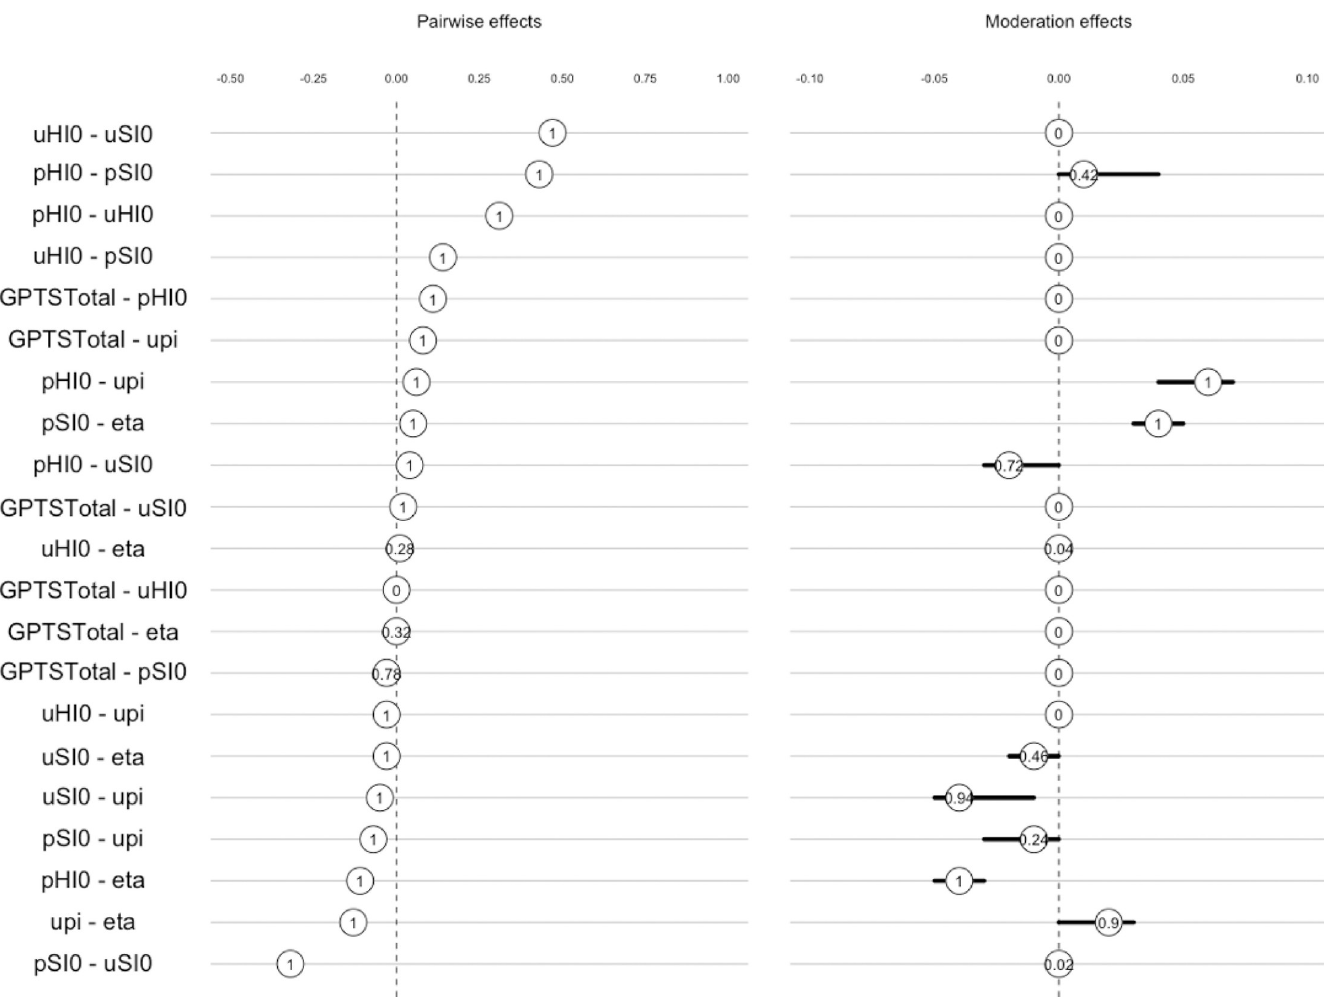
Fig 5. Moderation effects of pre-existing paranoia on edges within the Moderated Network Model (Fig 4B). The left panel displays the pairwise effects–the overall relationship between the parameters in the Gaussian Graphical Model of parameters—and the right panel shows the moderation effect of GPTS score on the pairwise effects–the influence of variable GPTS scores on the relationship between parameters. Both are shown with 95% confidence intervals of the bootstrapped sampling distributions. The number at the centre of the sampling distribution is the proportion of bootstrap samples in which a parameter has been estimated to be nonzero [26].